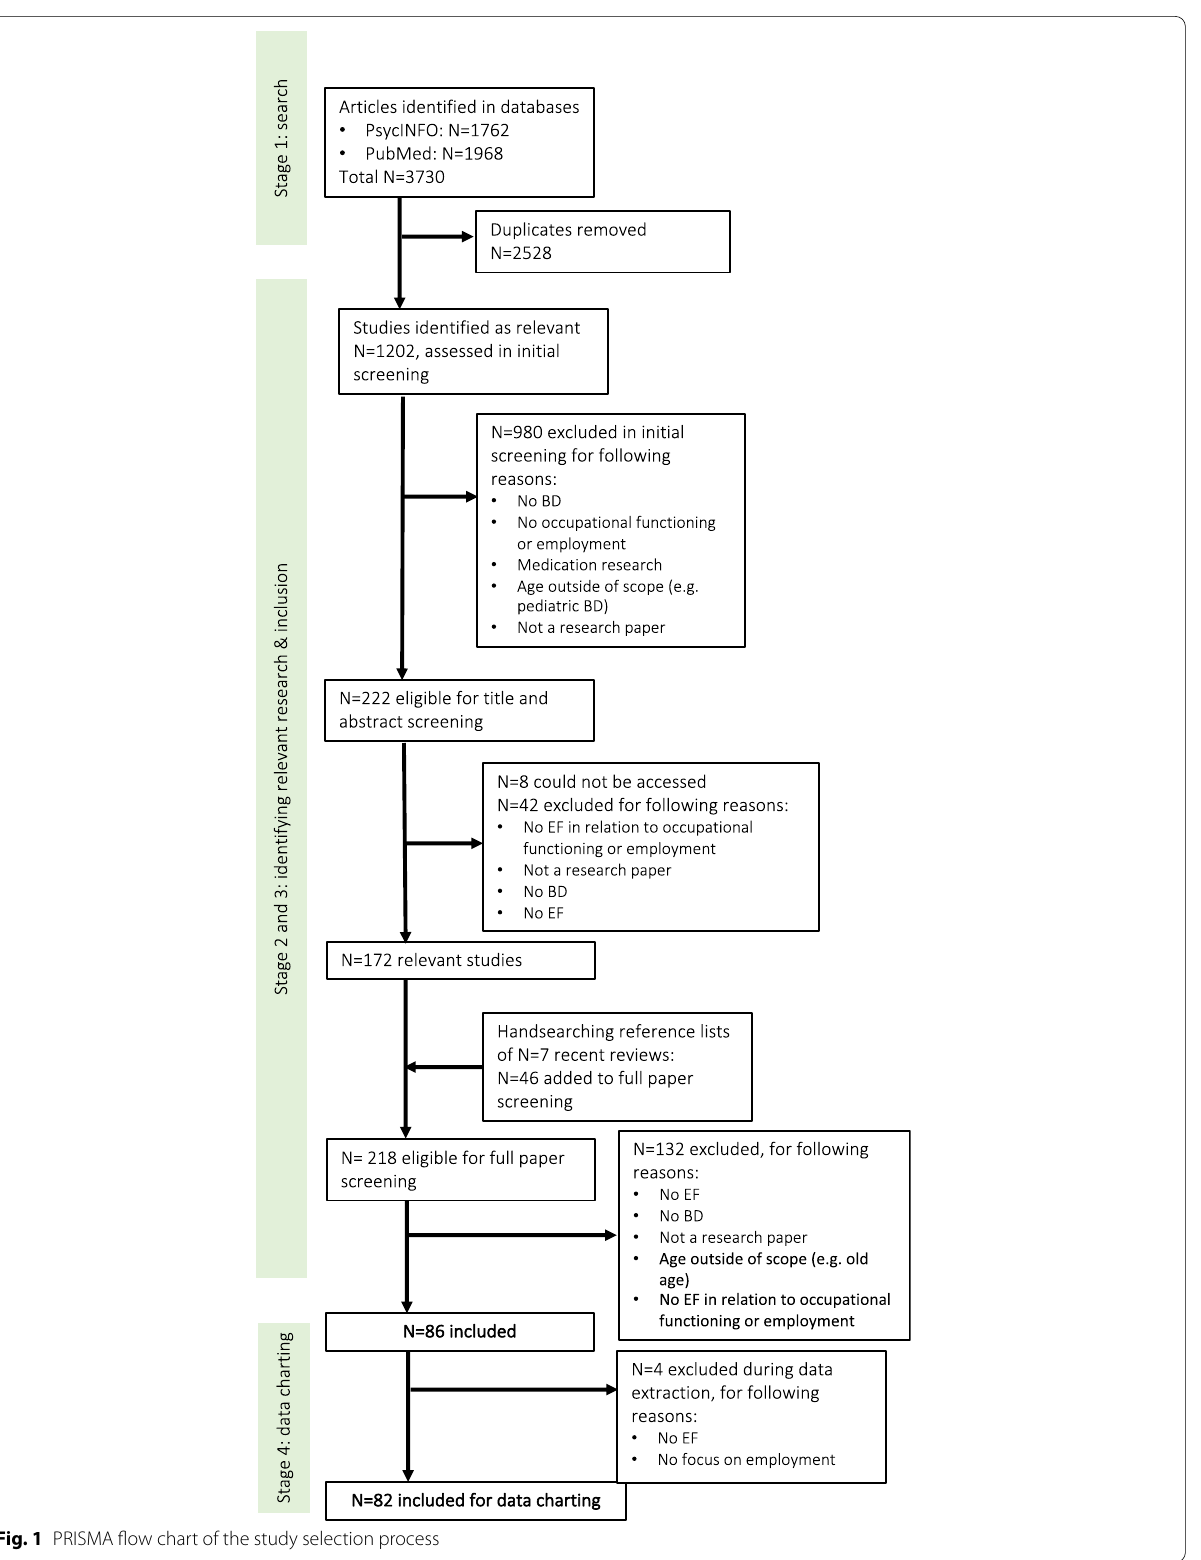
Fig. 1 PRISMA flow chart of the study selection